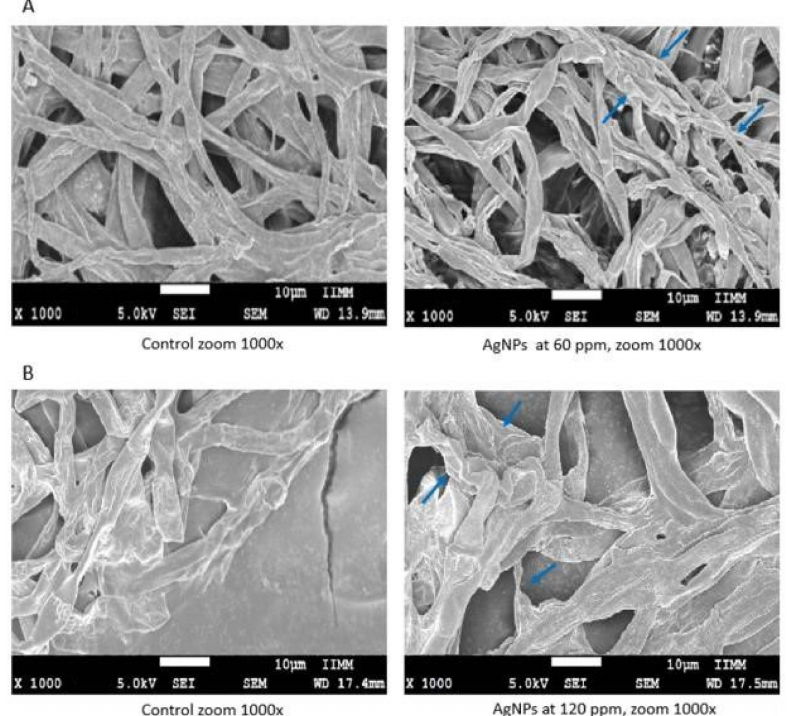
Figure 4. Mycelium under the electron microscope 1000 × : ( A ) Alternaria solani and ( B ) Macrophomina sp. The arrow mark in the image indicates the injury in the fungi